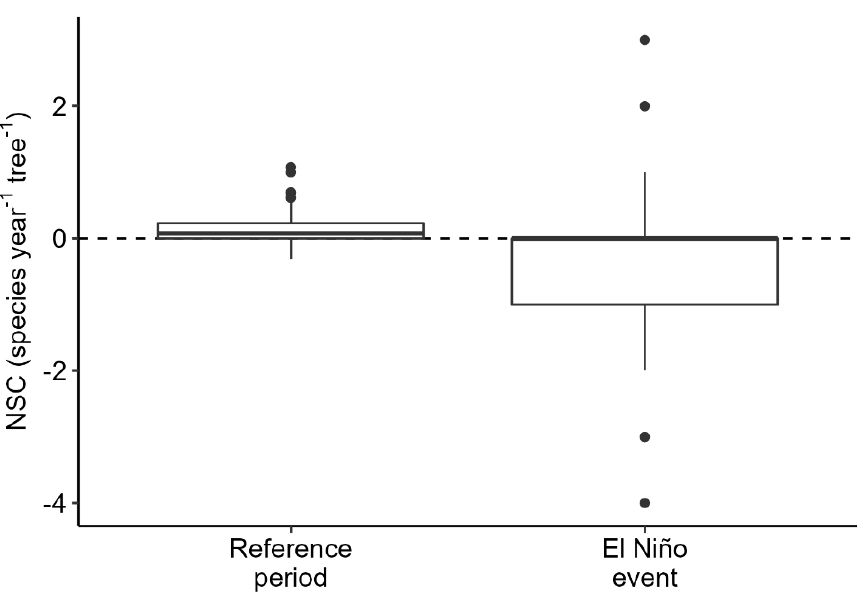
Figure 1. Net change in species numbers per year and tree individual (NSC, species year − 1 tree − 1 ) for the reference period and the 12 months with the El Niño event. The change in the number of epiphyte species per tree was significantly lower during the El Niño event ( t = 5.0, df = 144, p < 0.001, estimated mean of the difference: 0.4 species year − 1 tree − 1 ).